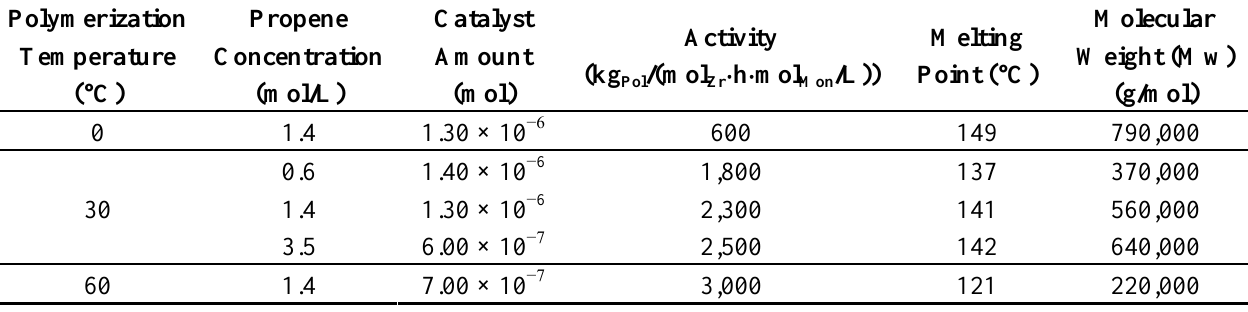
Table 3. Polymerization activity and polymer properties in relation to polymerization temperature, propene concentration, and catalyst